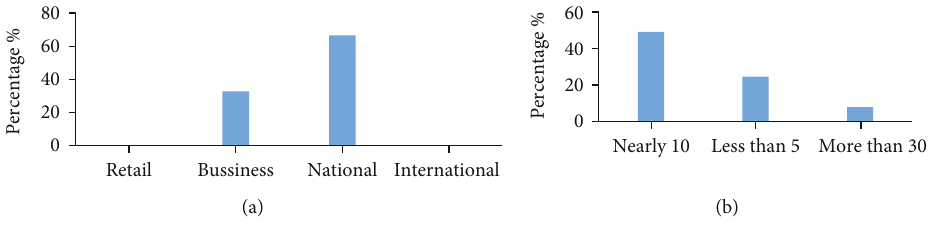
Figure 2: (a) Classi fi cation of the customers and (b) the number of the employees in each category. Table 9: Amount of investments in M$ in PV, wind, biomass, SWH, and EE from 2016 until